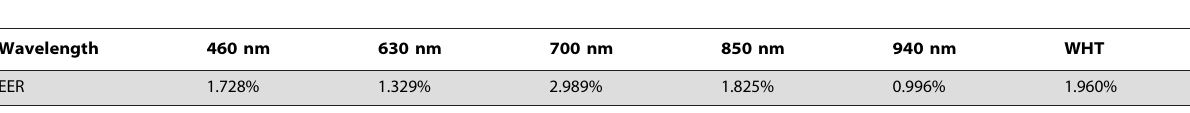
Table 4. Verification results from the CASIA multi-spectral palmprint